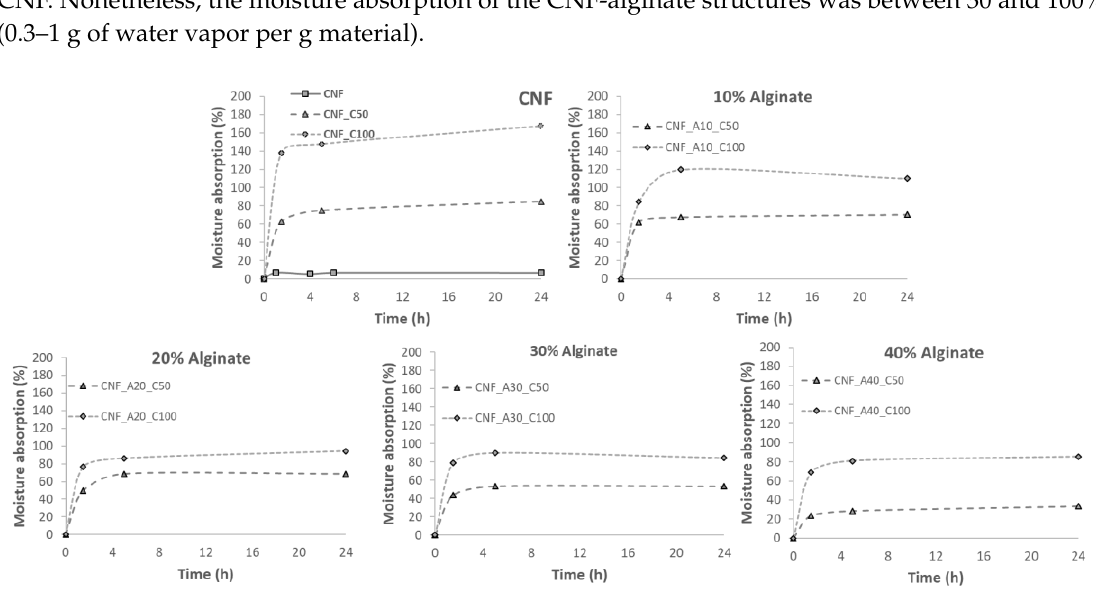
Figure 4. Moisture absorption curves for the different aerogels.